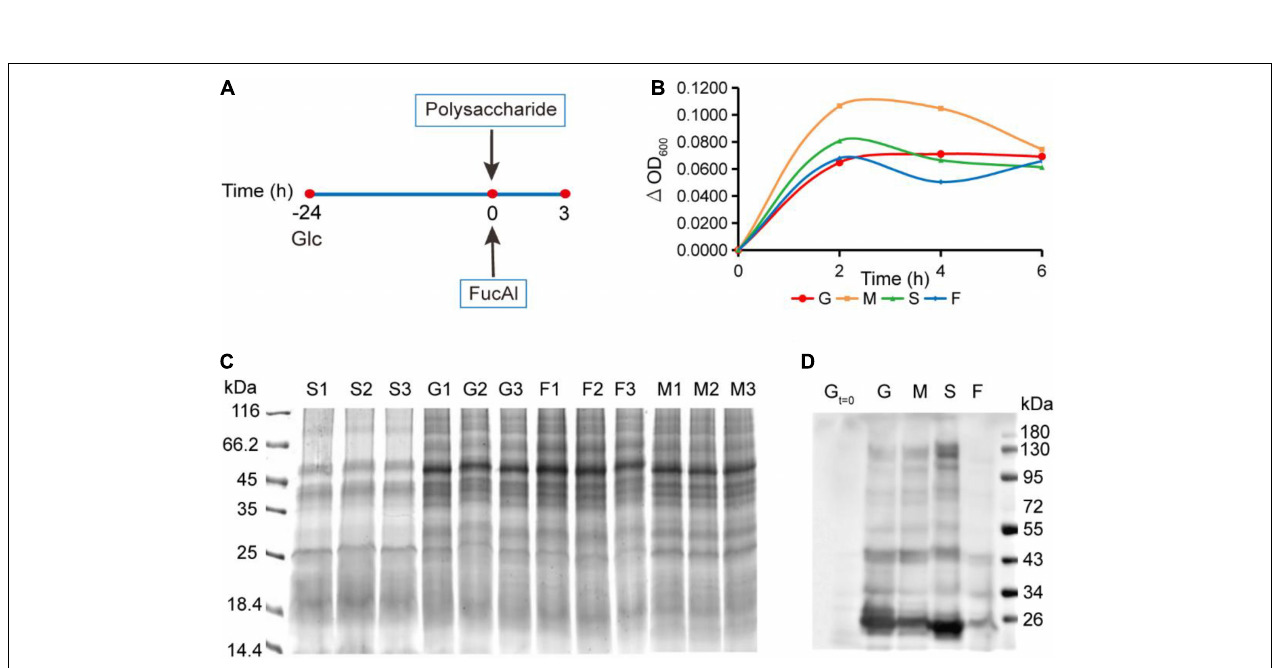
FIGURE 2 | Culture of B. thetaiotaomicron and enrichment of FGPs in different polysaccharide nutrition conditions. (A) Scheme for culture of B. thetaiotaomicron . B. thetaiotaomicron was incubated in AMM (0.5% glucose) under anaerobic conditions at 37 ◦ C for 24 h and grew to the middle logarithmic growth phase. No additional carbohydrate was added to the G group. Mucin (M group), starch (S group), and fucoidan (F group) were added into the corresponding group to a final concentration of 0.25% (m/v), respectively. 200 µ M FucAl was added at the same time. After 3 h, bacterial cultures were collected. (B) Growth curves of B. thetaiotaomicron under different polysaccharide nutrition conditions. G, glcucose; M, mucin; S, corn starch; F, fucoidan. (C) Gel imaging of global proteins in each experiment. (D) Western blot analysis of enriched FGPs in each group by anti-biotin antibody.